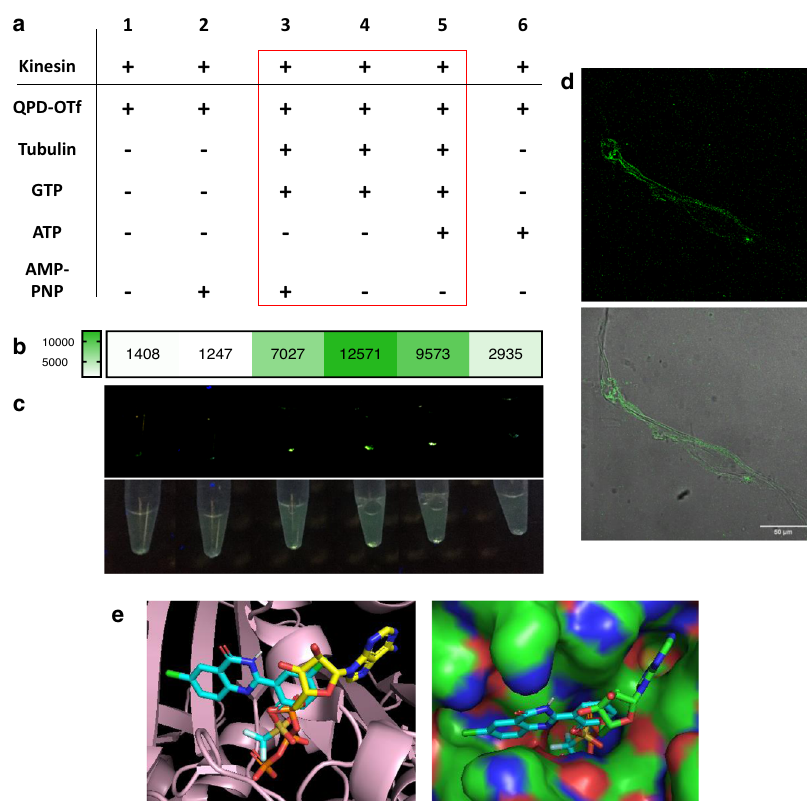
Fig. 6 In vitro and computational studies of QPD-OTf. a In vitro precipitation of QPD; table of conditions for the samples reported in c ; red square indicates the samples that gave detectable QPD- fl uorescence. b Intensity map of emitted light by samples 1 – 6 under 366 nm excitation; intensity values are expressed as gray values from the green channel of an RGB picture acquired with a smartphone camera. c Samples under 366 nm light: green channel (top); original picture (bottom). d Confocal imaging of fl uorescent fi laments contained in sample 4; green: crystal. Scale bar 50 µ m. e Docking of QPD-OTf into ATP binding site of kinesin-1. Left: QPD-OTf (cyan), ATP (yellow), kinesin-1 (pink); right: QPD-OTf (cyan), ATP (green), kinesin-1 (polarized surface). Source data are provided as Source Data fi